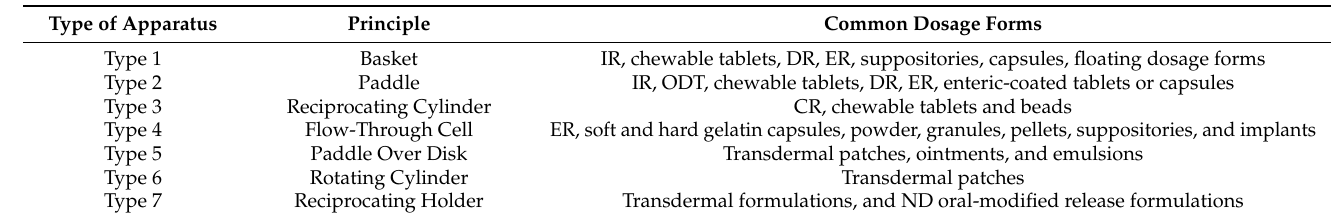
Table 2. USP dissolution apparatus. IR—Immediate release, DR—Delayed release, ER—Extended release, ODT—Oral disintegrating tablets, ND—Non-disintegrating, CR—Controlled release